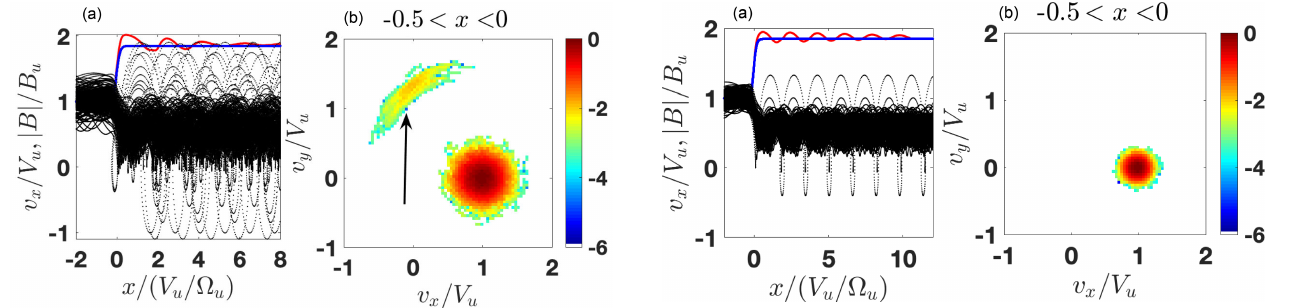
Figure 6. (a) The modeled (blue) and the predicted (red) magnetic profiles as well as the ion orbits x vs. v x . (b) A slice of the ion distribution inside the ramp. The shock parameters are M = 1 . 9,